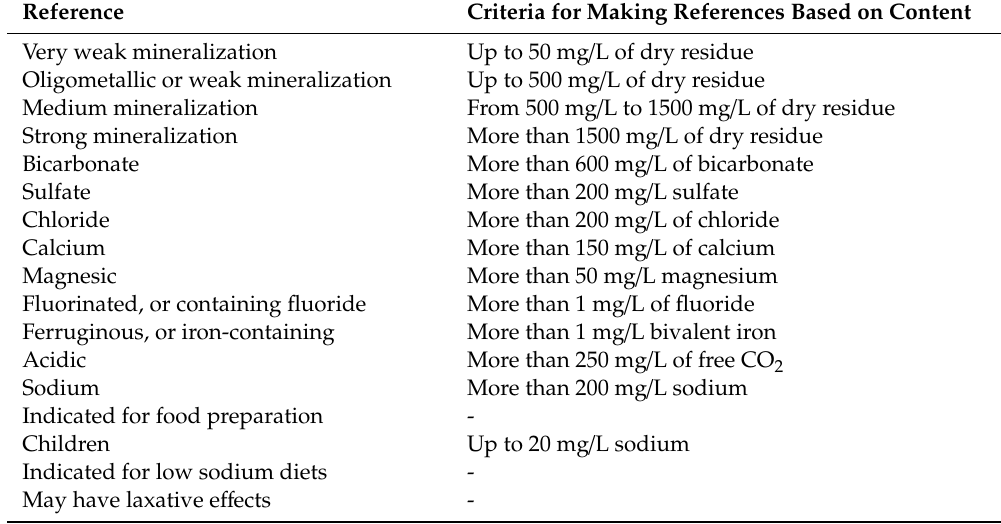
Table A1. Characteristics of natural mineral water. Source: Royal Decree 1798 / 2010, The O ffi cial State Gazette, No. 16, 19 January 2011.